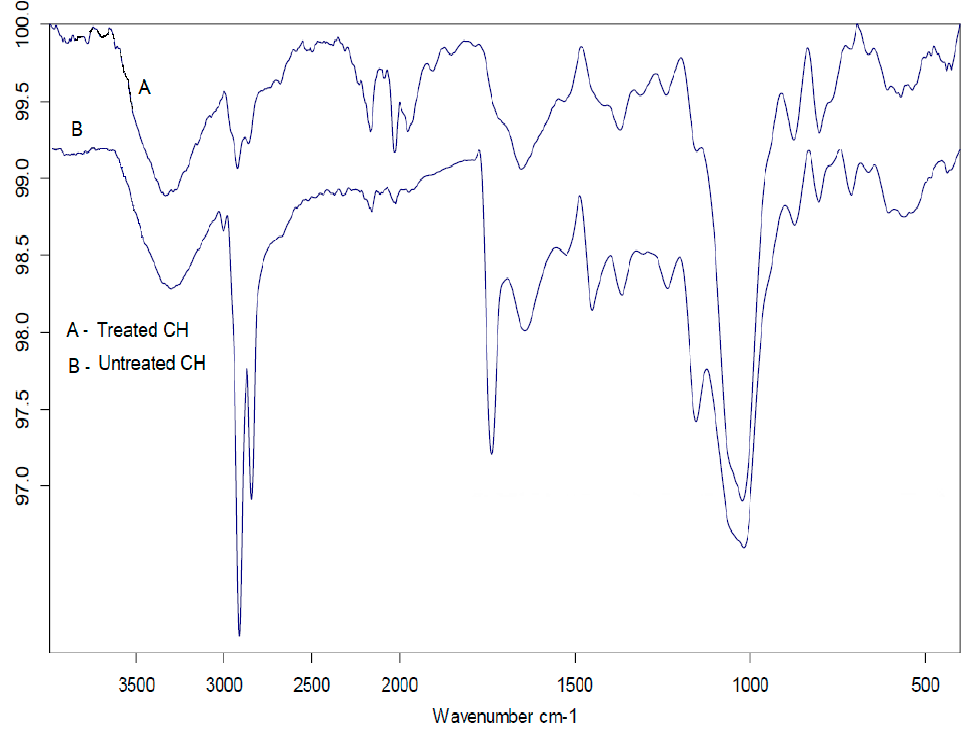
Figure 2. Comparative FTIR spectrum of treated and untreated co ff ee husk (CH) . The “stretching vibrations” of -O–H and C–O–C associated with cellulose as well as lignin in the CH were represented by the peaks near 3310 cm − 1 and 1152 cm − 1 . The dis- tinctive peak for the C-H bond “bending vibration” was well-represented by the distinc- tive peak at 1376 cm − 1 . The “stretching vibrations” of aldehydes and ketones were as- cribed to the peaks positioned at 1739 and 1648 cm − 1 . In FTIR spectroscopic identi fi cation, as well as quanti fi cation of ca ff eine in co ff ee extract samples, the spectroscopic response at 1648 cm − 1 has been regularly referred to as the “chemical descriptor” of ca ff eine [34]. Carboxyl group C-O bond “stretching vibration” could be held responsible for a peak at 1445 cm − 1 . The peak at 1238 cm − 1 relates to the C–N “stretching vibration” of the amine group [35–40]. A fragile signal at around 1800 cm − 1 is credited to the “carbonyl (CO) vi-